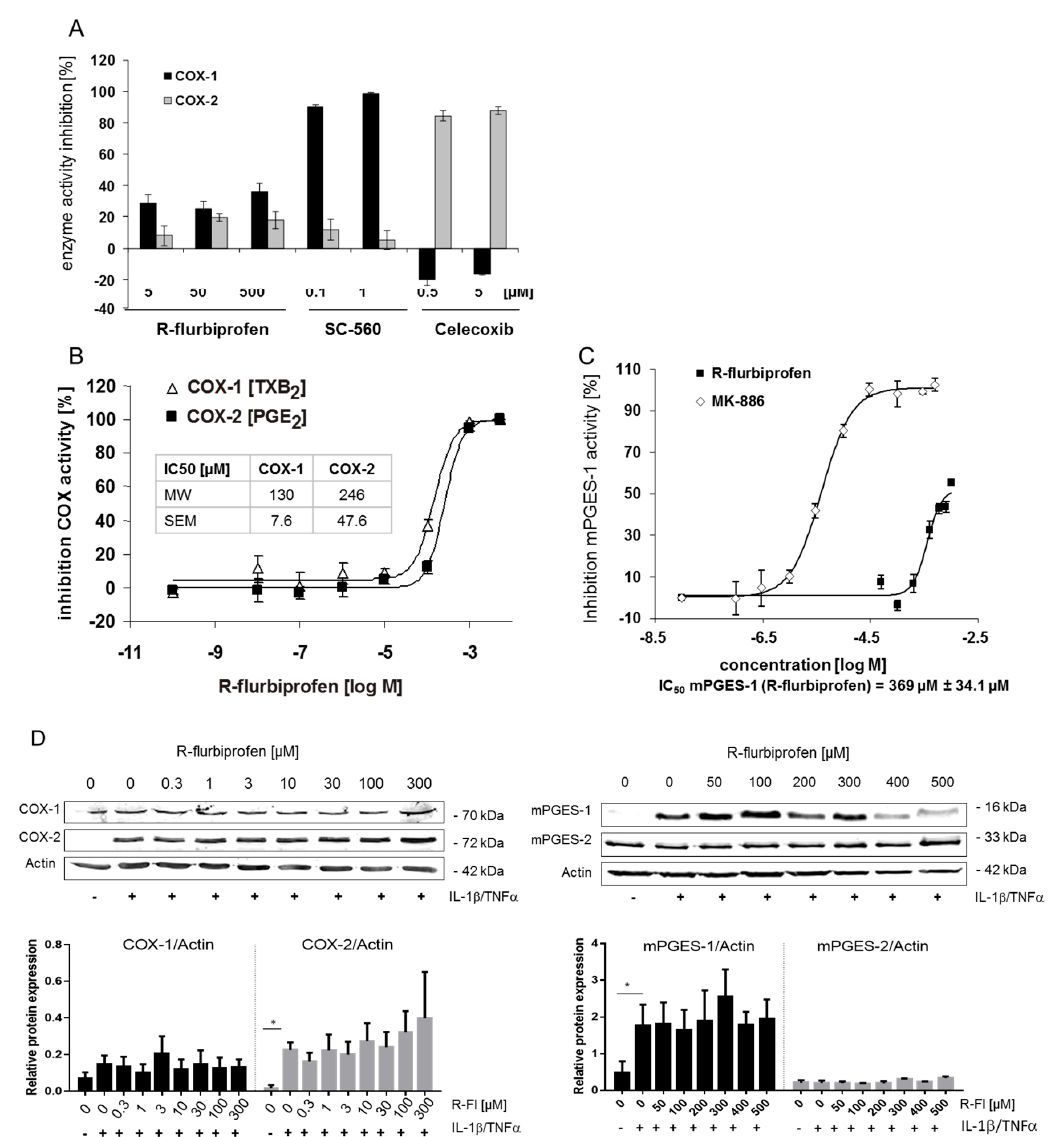
Figure 2. ( A ) COX inhibitor screening assay: in vitro inhibition of purified COX-1 and COX-2 protein by R -flurbiprofen, SC-560, and celecoxib. R -flurbiprofen inhibited COX-1 and COX-2 activity only marginally, without concentration dependency. Means ± S.E.M. of four independent experiments; ( B ) Human whole-blood assay in vitro: human blood was pre-incubated with R -flurbiprofen or vehicle (DMSO) and subsequently stimulated either with Ca 2+ -ionophore (20 µM A23187) for induction of COX-1 activity, resulting in the formation of thromboxane B 2 (TXB 2 ), or with LPS (5 mg/mL) for induction of COX-2 activity, resulting in the formation of PGE 2 . IC 50 values were calculated using a sigmoid Emax model. Data presented are means ± S.E.M. of four independent experiments; ( C ) mPGES-1 activity assay: mPGES-1 activity was measured in the microsomal fraction of HeLa cells in vitro. R -flurbiprofen only marginally affected mPGES-1 activity, with an IC 50 of about 370 µM. In contrast, MK-886 inhibited mPGES-1 activity with an IC 50 of 4 µM. IC 50 values were calculated using a sigmoid Emax model. Data presented are means ± S.E.M. of four independent experiments; ( D ) Western blot analysis of COX-1 and COX-2 (whole cell lysate) and mPGES-1/2 (microsomal fraction). One representative experiment out of three is shown, as well as the quantification of three Western blots. Data presented are means ± S.E.M. of three independent experiments; statistical analysis was done with one-way ANOVA. Significant p values are shown as: * p ≤ 0.05.